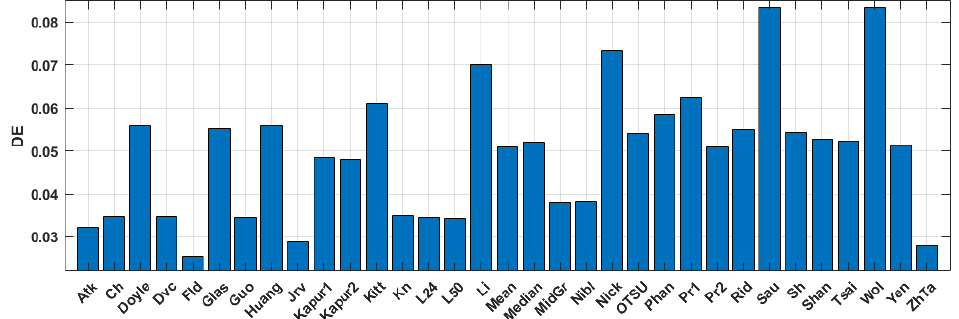
Figure 7. Average DE values for the binary amplitude inline Fresnel holograms.